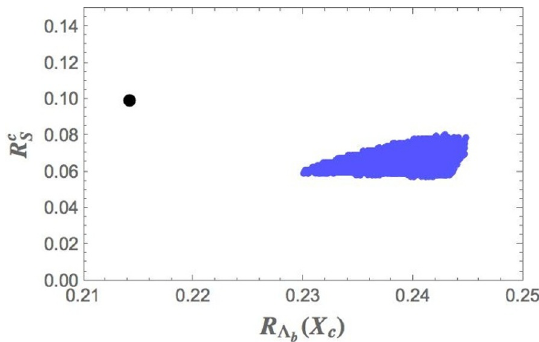
Figure 12 . (cid:3) b ! X c (cid:28) (cid:22) (cid:23) (cid:28) : correlation between R (cid:3) distribution. The dot corresponds to SM, the broad region to NP with the e(cid:11)ective couplings varied as speci(cid:12)ed in the